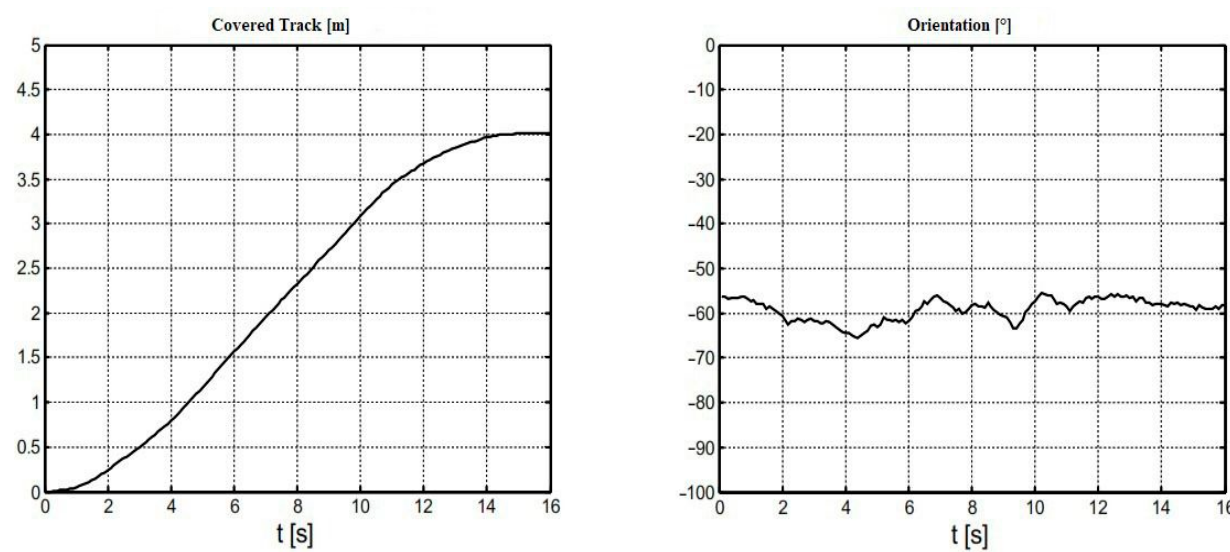
New Figure 6 caption: Position of the robot in the X-Y plane.